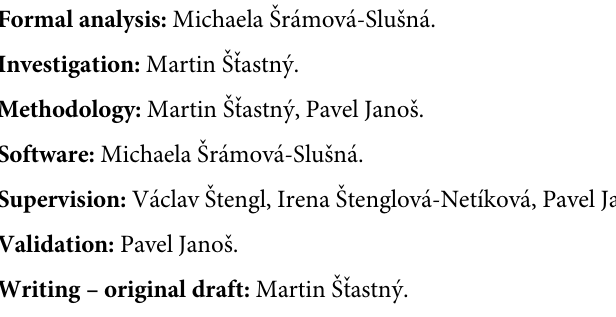
tion (Table B) and supplementary figures: LC-MS chromatograms (Figures A-C, E, and F) and mass spectra (Figures D, F, and